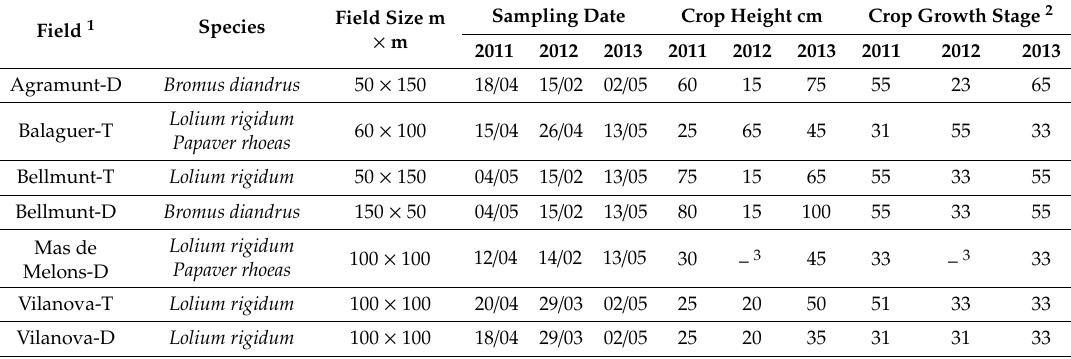
Table 2. Main weed species of each field, sampling area, and date and crop development at the time of